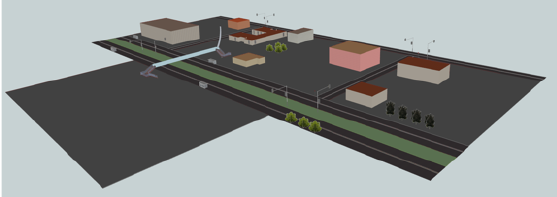
Figure 14: The CityGML model in FZK Viewer